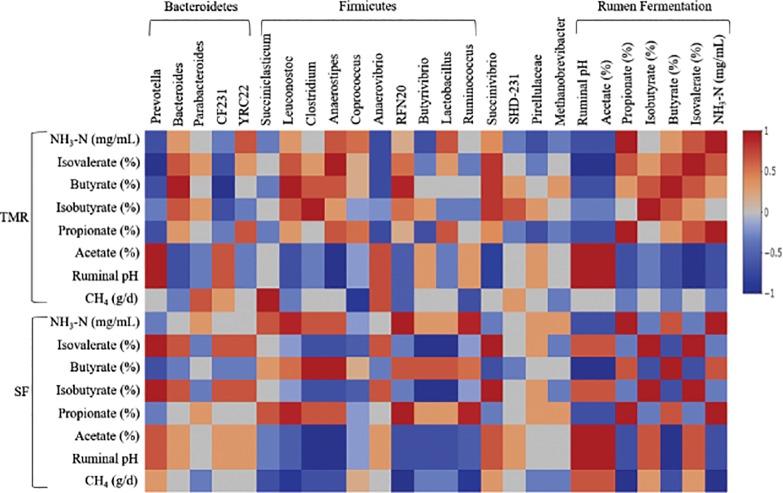
Correlation between efficiency parameter and genus abundance.Kendall’s non parametric correlation matrix of the dominant bacterial genera across the rumen samples. The genera were included in the matrix if they were in at least 50% of the steers and represented at least 0.1% of the bacterial community in at least one of the steers. Mean values of different time intervals were included for both microbial abundance and production parameters. Strong correlations are indicated by the intensity of the color. The scale colors denote whether the correlation is positive (closer to 1, red squares) or negative (closer to -1, blue squares) between the genera and the efficiency parameters.